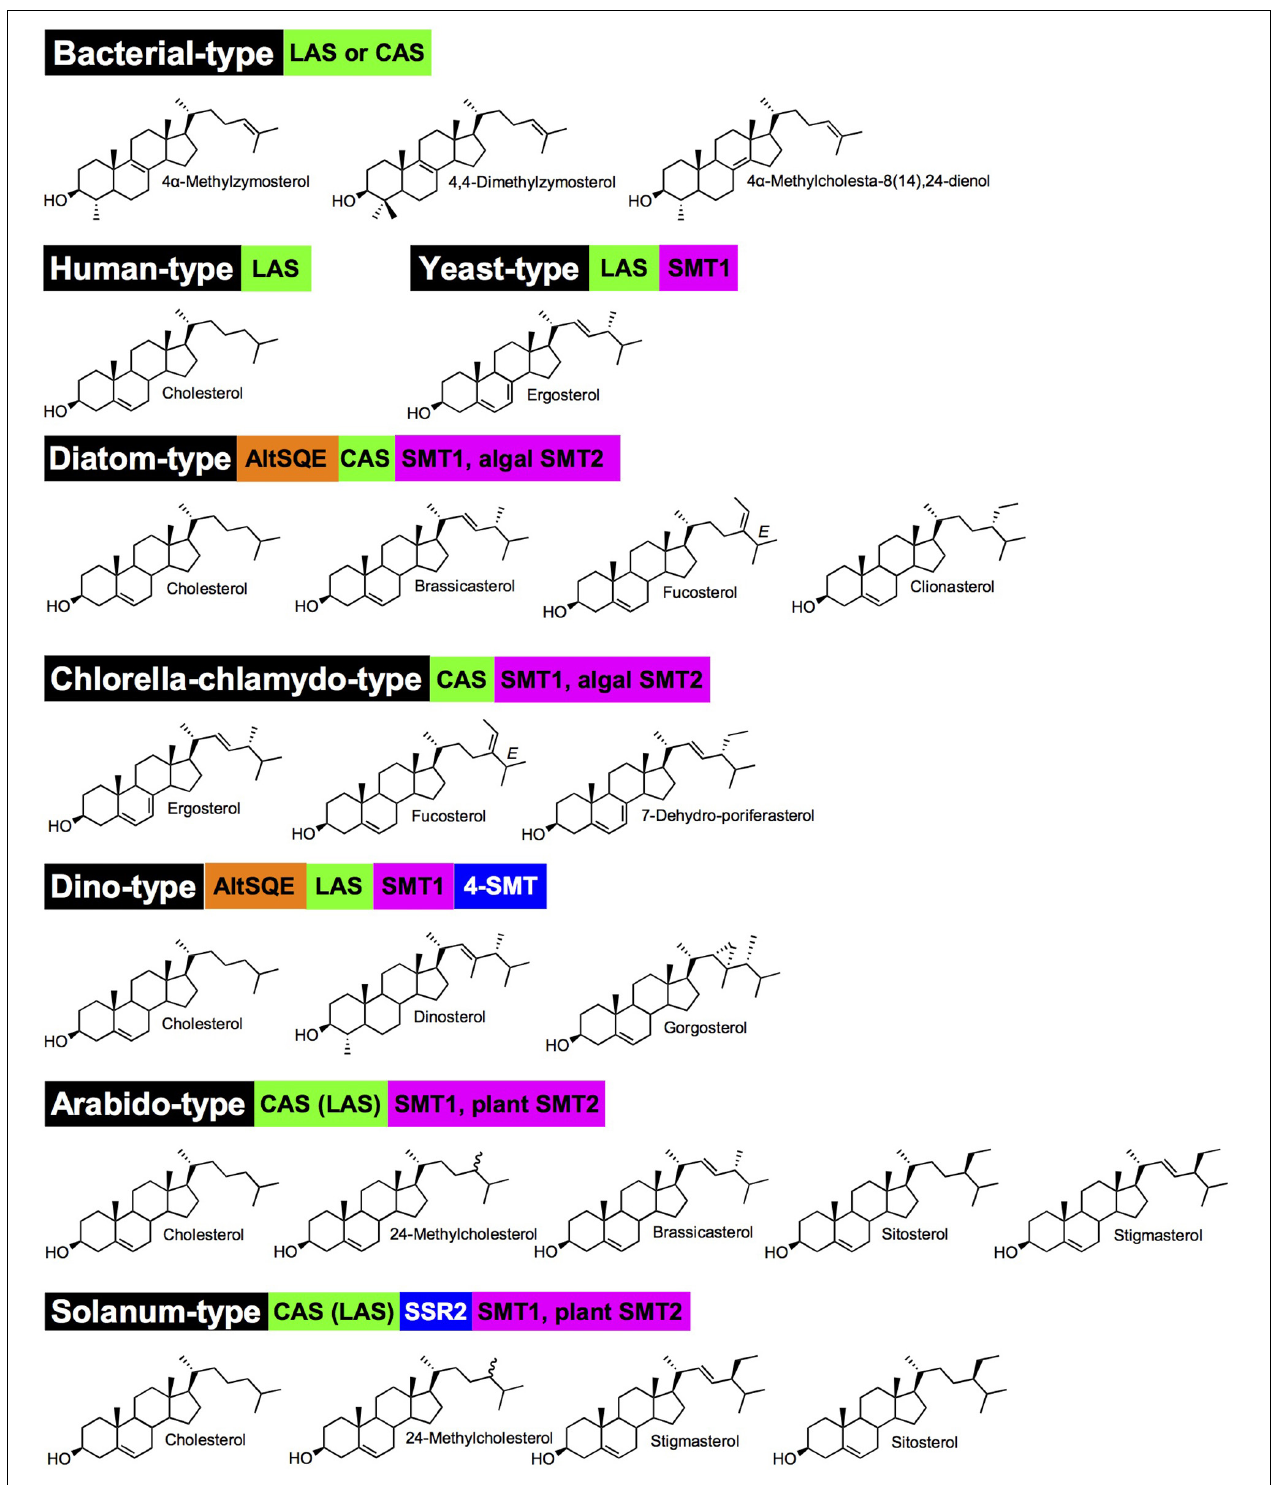
FIGURE 2 | Major sterolotypes defined in living organisms. Names in black boxes are chosen according to species or taxonomic groups for which a sterol pathway is well documented. Green boxes indicated whether a CAS (cycloartenol synthase) or LAS (lanosterol synthase) defines a sterol pathway; brackets are for minor contribution of a pathway as currently understood. Orange boxes are marking an AltSQE, alternative squalene epoxidase (canonical SQE otherwise not indicated in sterolotypes). Blue and magenta boxes are for sterol side chain modifications by SSR2 (sterol side chain reductase 2), SMT, sterol-C-methyltransferases. Major or representative sterols are represented for each sterolotype. Nomenclature as in Figure 1 . Arabido-type and Solanum-type exhibit the epimeric pair of campesterol (C24 α -methylcholesterol) and 22(23)-dihydrobrassicasterol (C24 β -methylcholesterol) represented by 24-methylcholesterol.